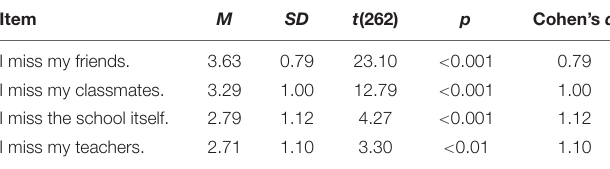
TABLE 5 | Means, standard deviations, t-statistics, and effect size.